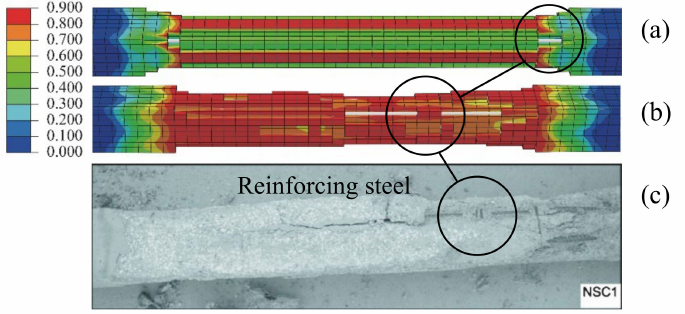
Figure 7. FEM damage and test damage of RC column. ( a ) Perfect bond; ( b ) Bond-slip; ( c )